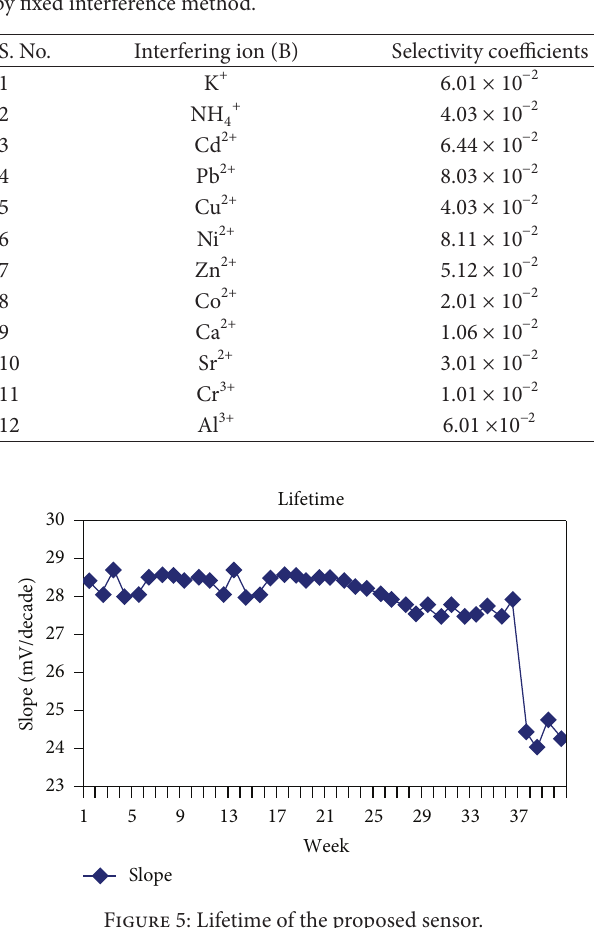
T 3: Selectivity coefficient values